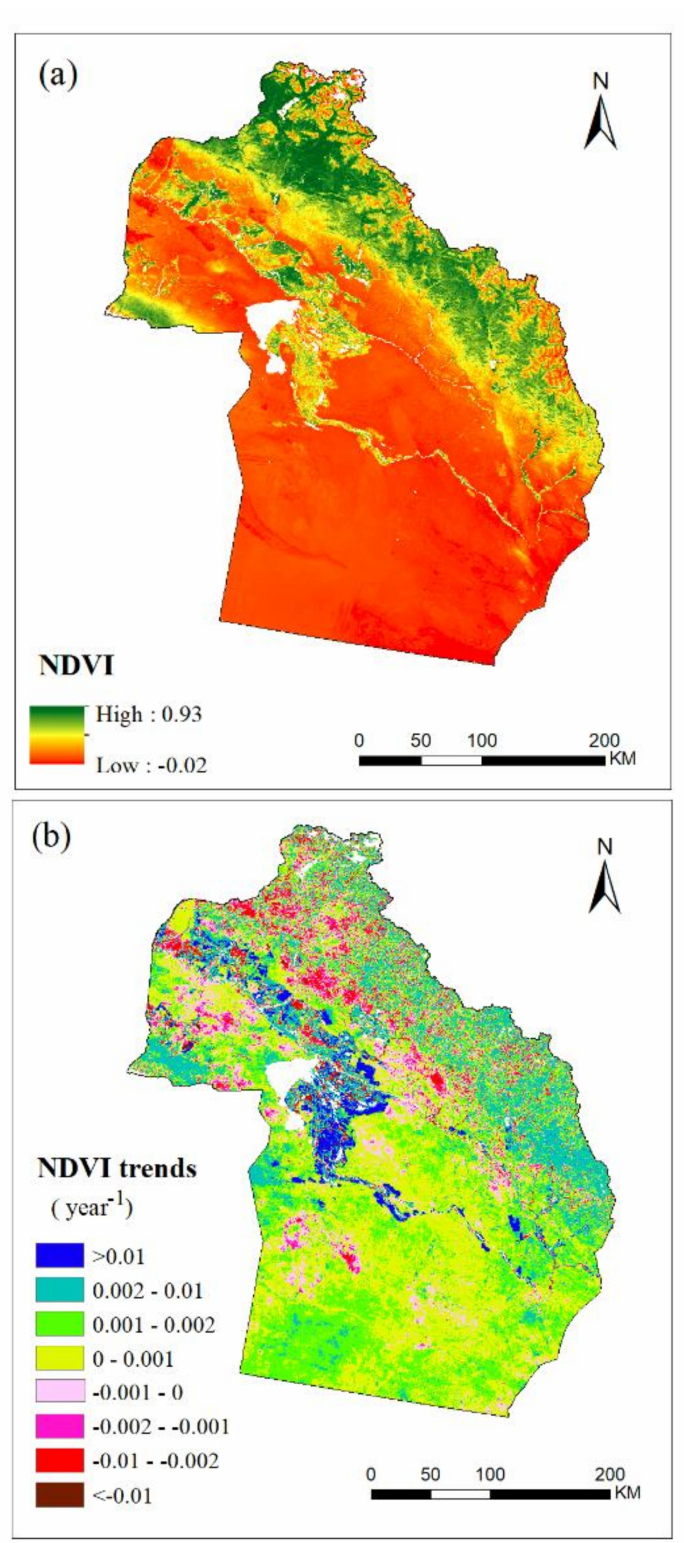
Figure 2. Spatial distribution of mean annual normalized di ff erence vegetation index (NDVI) values in Altay Prefecture during 2000–2017 ( a ) and trend map of NDVI values in Altay Prefecture during 2000–2017 ( b